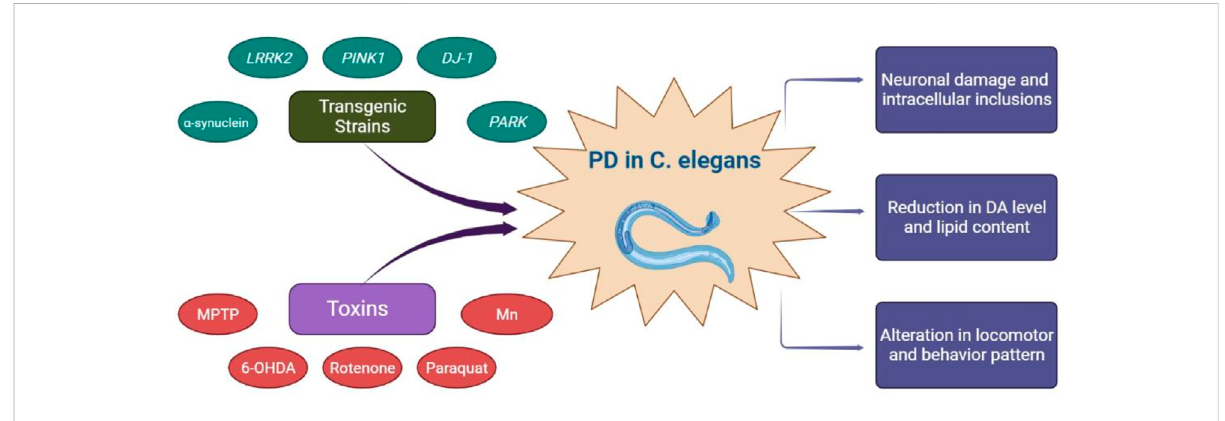
FIGURE 2 C. elegans models for Parkinson ’ s disease and their pathological